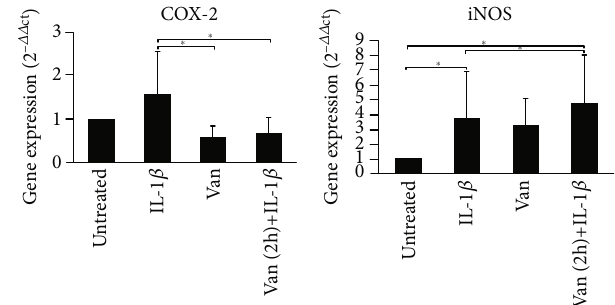
Figure 4: Gene expression of COX-2 and iNOS in HGF cells. Data are reported as mean and 95% CI, of three independent experiments, ∗ p < 0 : 05 . IL-1 β : IL-1 β -primed cells; Van: Vanillin;